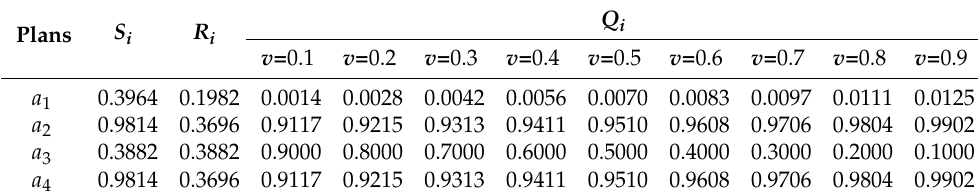
Table 17. The Q i value of the expropriator at different v values.